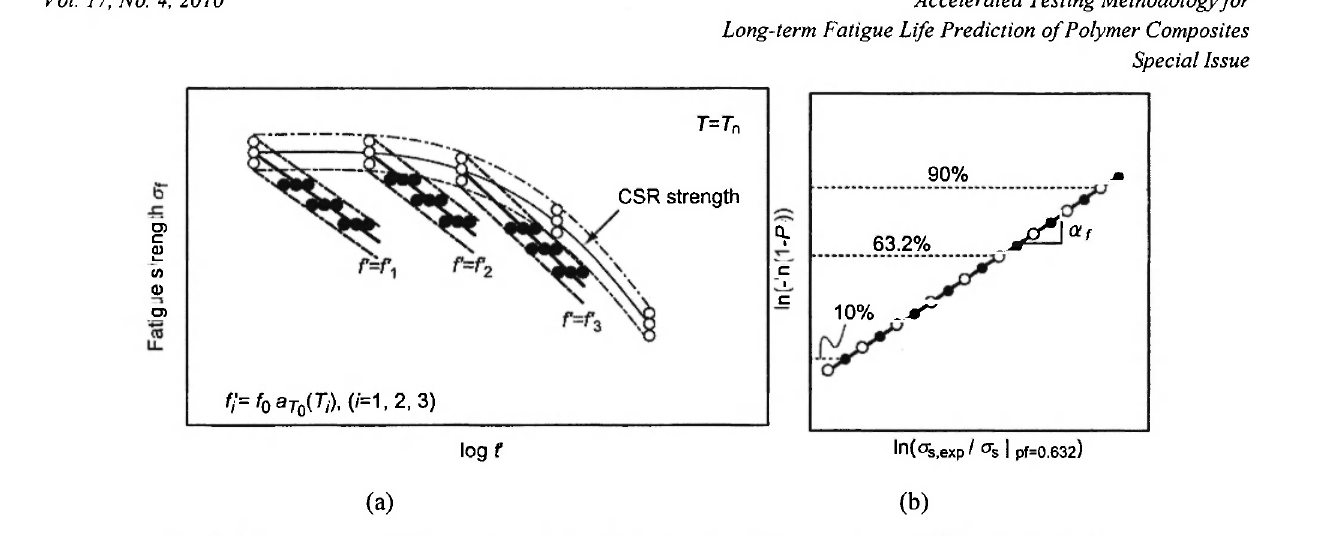
Fig. 7: Master curve of fatigue strength for distinct reduced frequencies and Weibull distribution